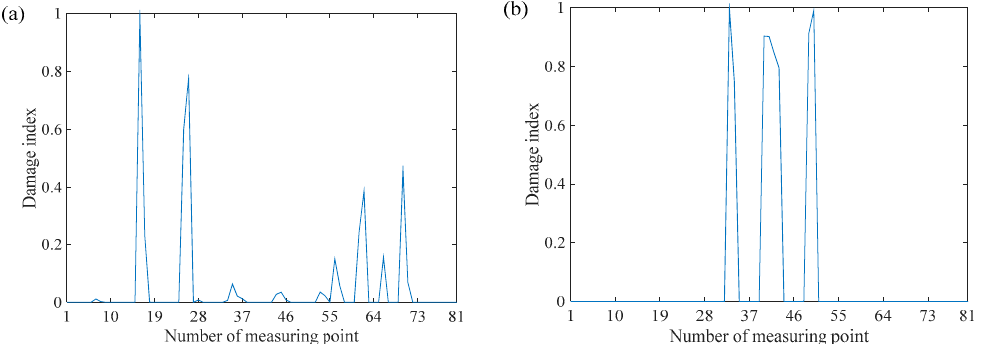
Figure 3. Damage detection results: ( a ) damage case 1 and ( b ) damage case 2.